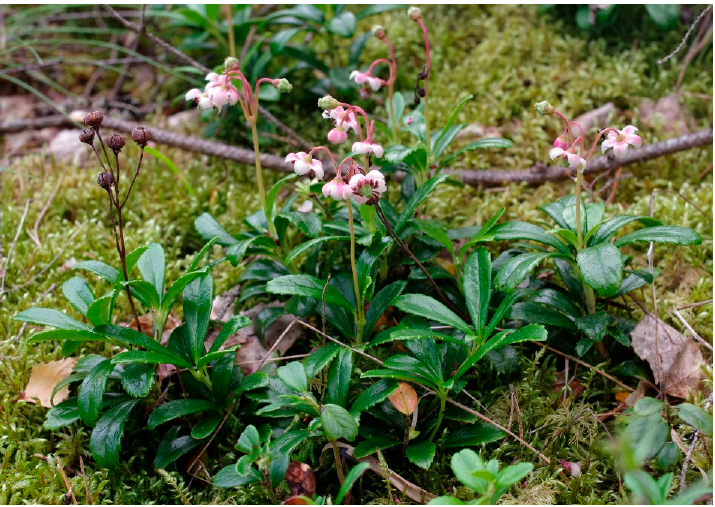
Figure 3. Chimaphila umbellata , a species favored by historical human use of boreo-nemoral forests, mainly livestock grazing. (Photo: Anna Lundell, July 2013).